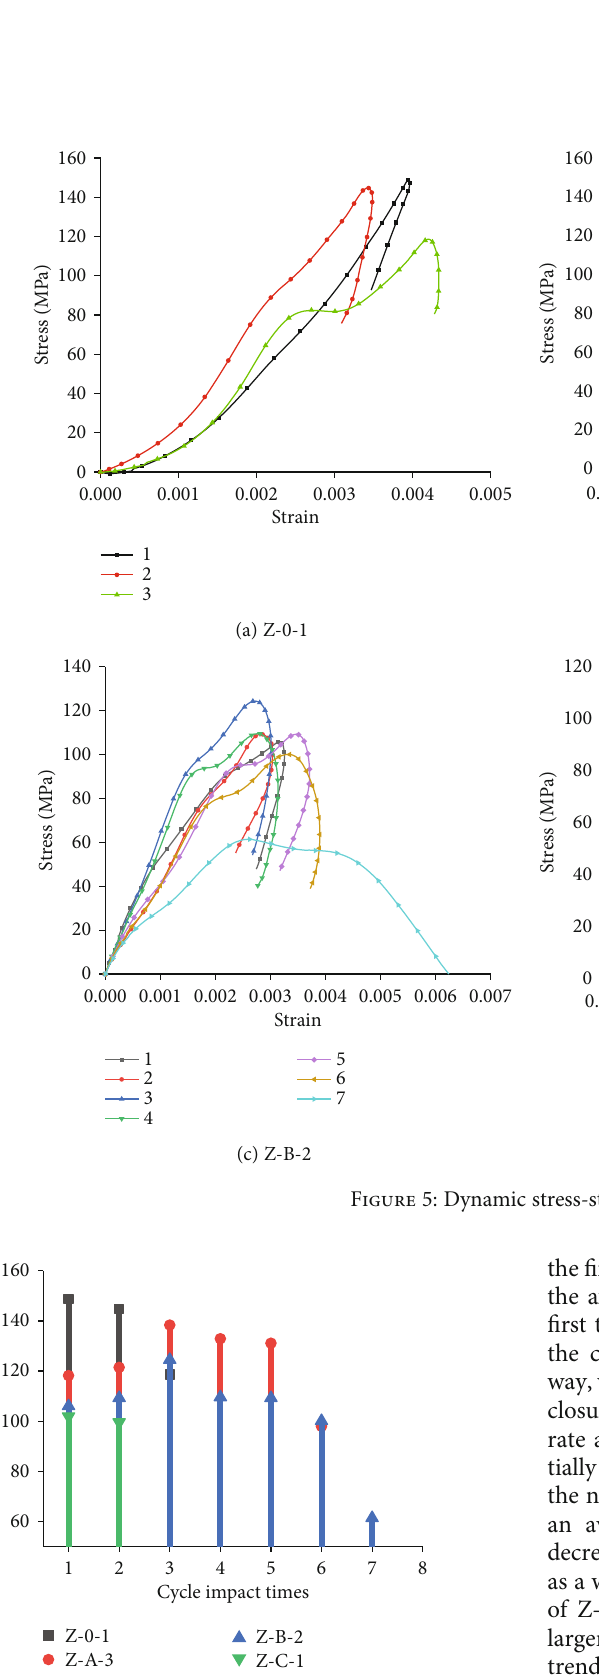
Figure 6: Relationship between the peak stress and cycle impact